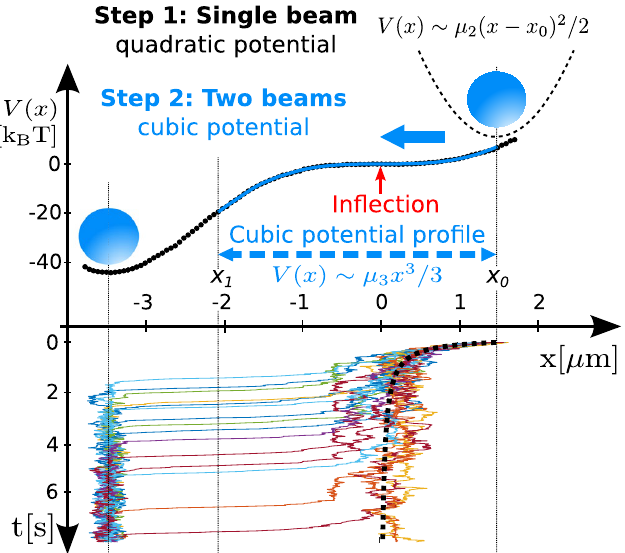
Figure 1. Principle of the experiment and examples of measured trajectories. Step 1: The particle (blue spot) is trapped in a single beam and follows Brownian motion in a quadratic potential close to its bottom. Step 2: The single beam is replaced with two co-propagating beams displaced in x -axis to form a non-linear single-well potential (dotted) with a cubic part (blue) along x -axis. Consequently the particle moves down the potential well (indicated by a blue arrow) passing through the cubic part and reaching the global minimum. Then the two beams are replaced with a single beam which confines the particle near the former global minimum and transports it to the initial position x 0 . Steps 1 and 2 are repeated with the same particle to get a statistical ensemble. The dotted curve denotes the reconstructed potential profile (in k B T units) from the particle trajectories and a fit to the cubic potential profile gives μ 3 = (6.65 ± 0.05) k B T / μ m 3 . A few measured trajectories are plotted as colour curves at the bottom part of the figure and the dashed one shows the deterministic trajectory without the influence of Brownian motion corresponding to T =